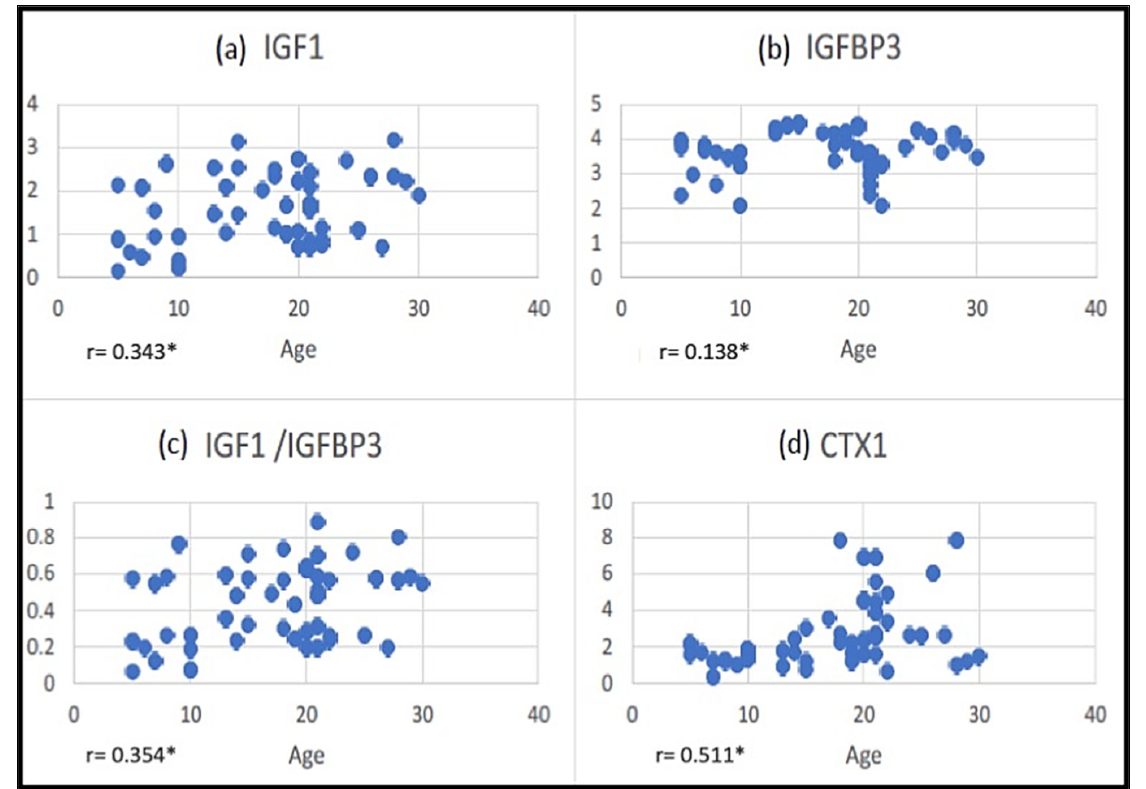
Figure 1. Correlation between ages with ( a ) IGF-1, ( b ) IGFBP-3, ( c ) IGF-1/IGFBP-3, and ( d ) CTX1. * Statistically significant.